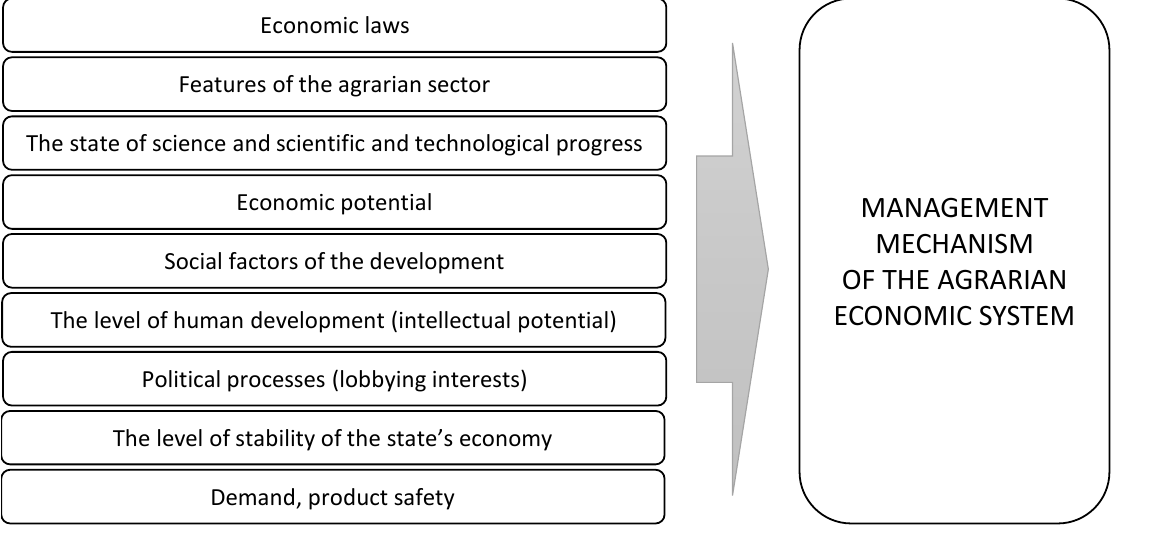
Figure 4. Factors of management mechanism of the agrarian economic systems